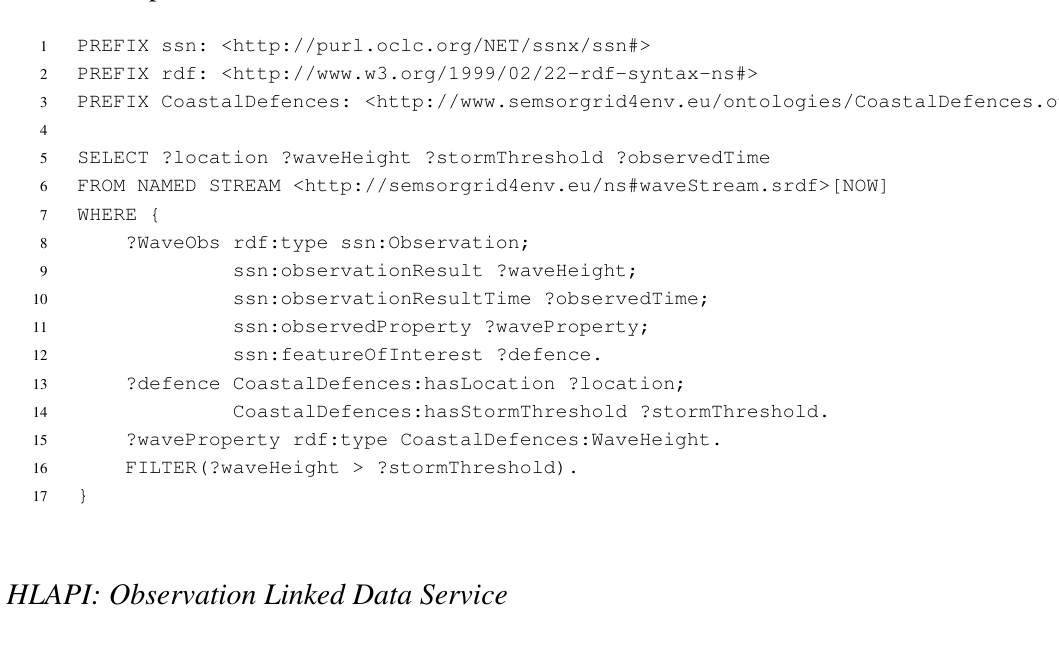
Figure 6. Declarative query in the SPARQL over-topping event over an ontological observation model for sea-state readings. The event is characterised by the measured wave height being greater than the associated storm threshold value for a specific